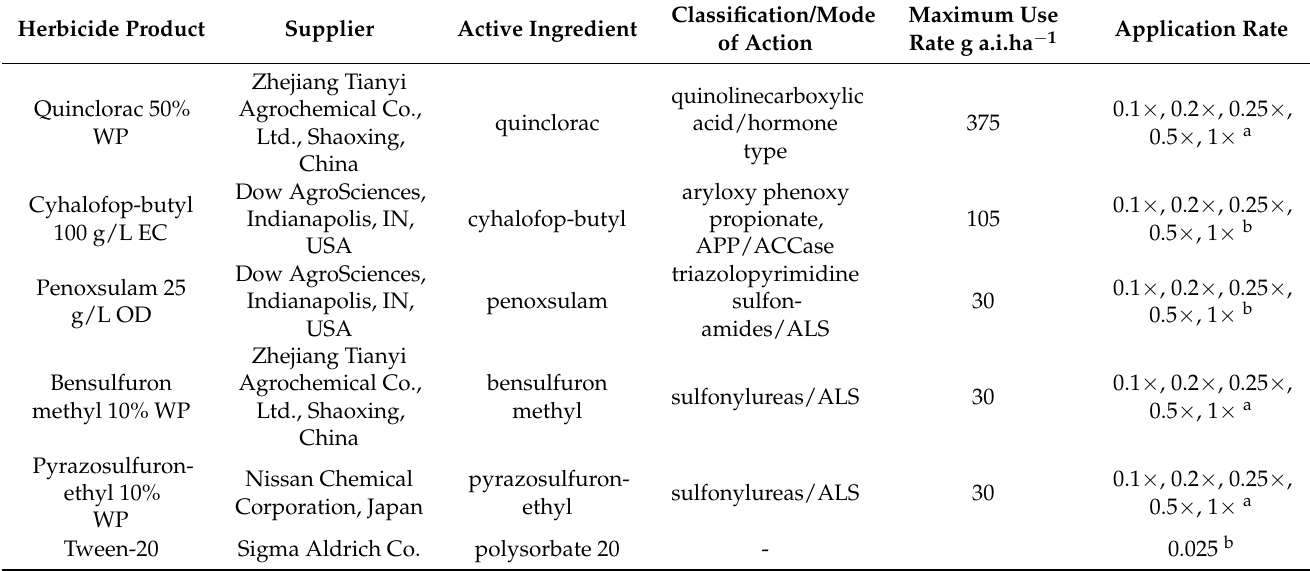
Table 6. Commercial formulations of herbicides and adjuvants evaluated for compatibility with B. eleusines